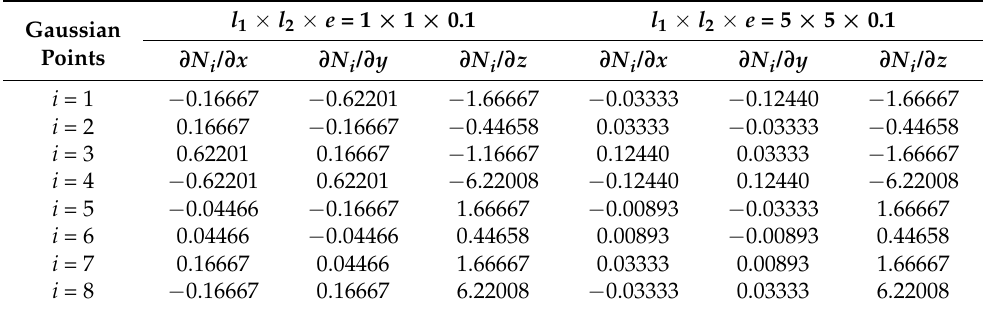
Table 1. The value of partial derivatives of the shape functions of thin layer elements with respect to the local coordinates at Gaussian